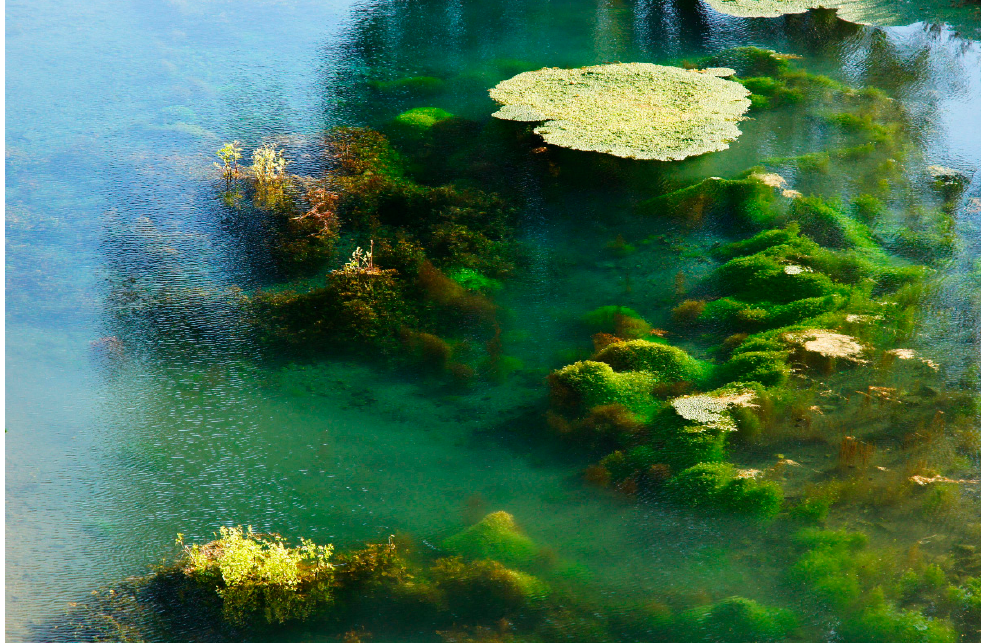
Figure 2. Potametum alpini in the limnocrene karst spring in Poland.